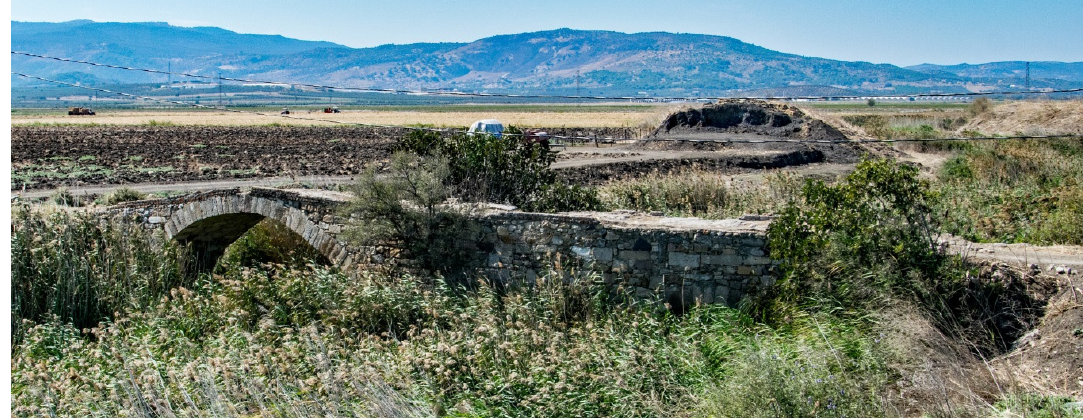
Figure 4. Hac ı ismail Köprüsü (bridge 4) in the western lower Bak ı rçay Valley. Figure 4. Hacıismail Köprüsü (bridge 4) in the western lower Bakırçay